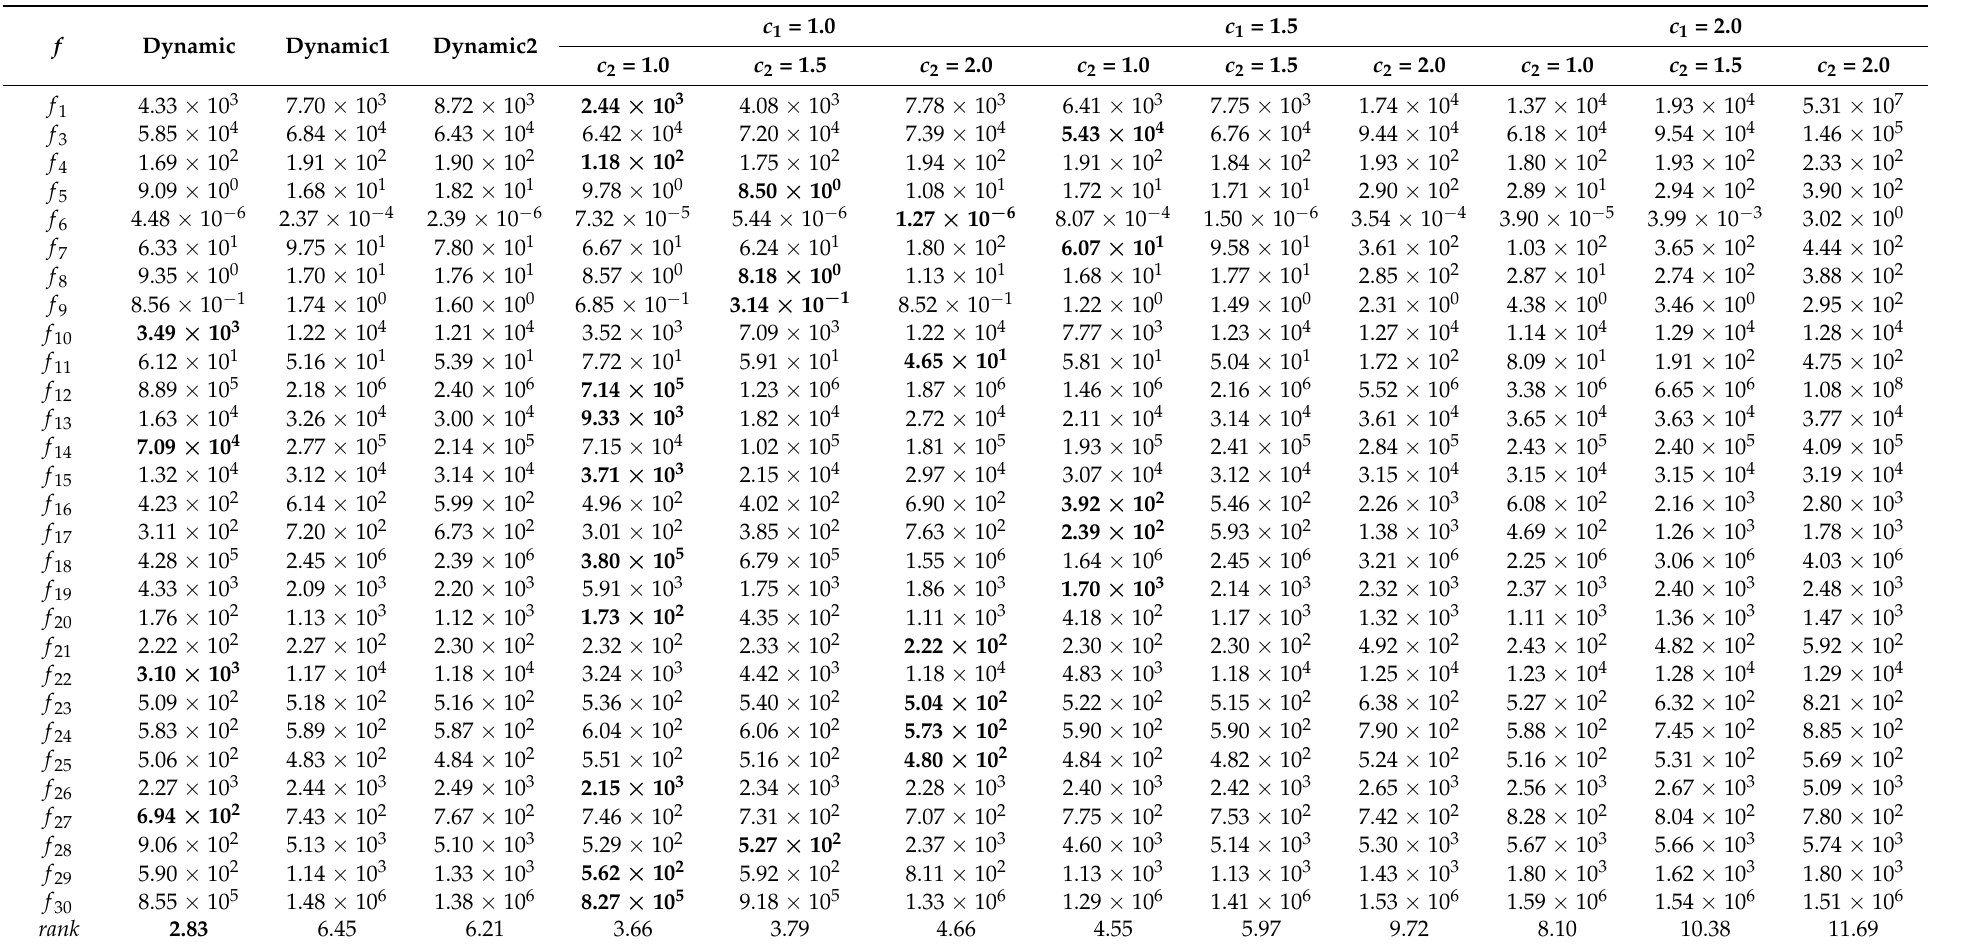
Table 9. Comparison results between STTPSO with different acceleration coefficient settings on the 50 D CEC 2017 functions. The best results are highlighted in